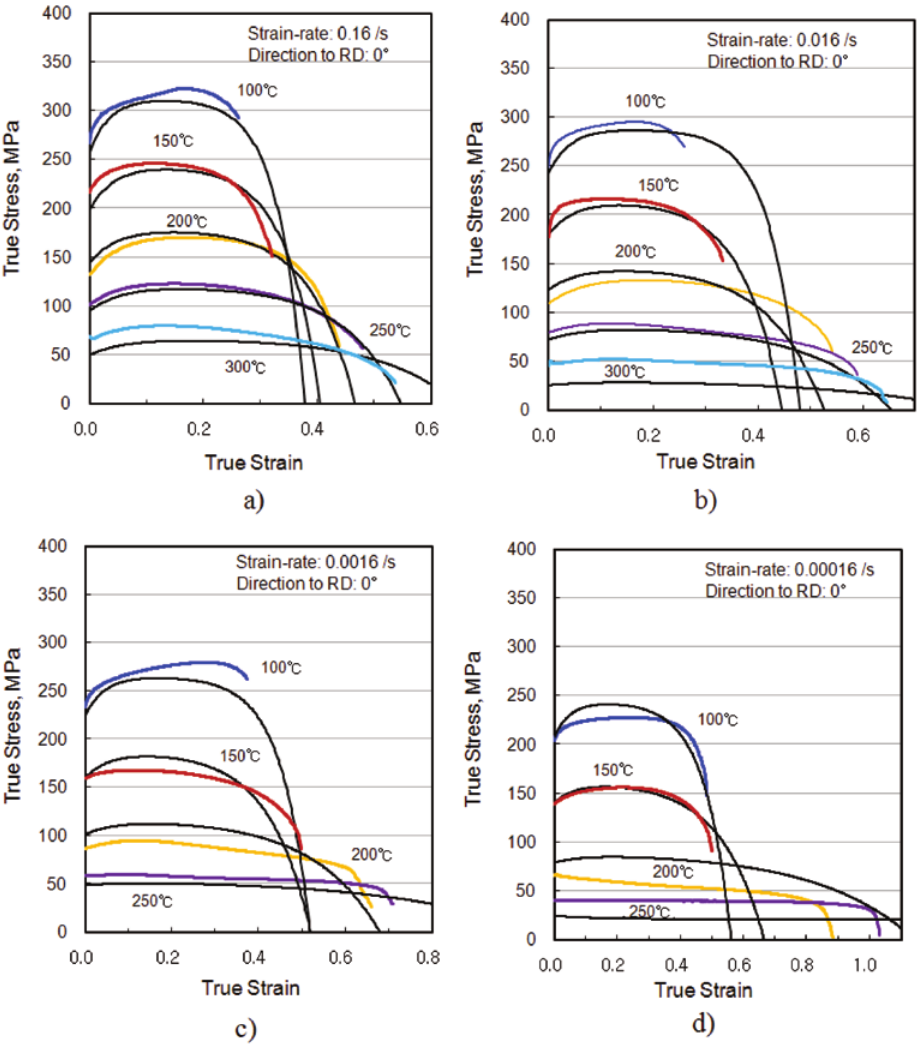
Fig. 5: Comparison between proposed model and experimental flow stress curves at elevated temperatures and strain rates: (a) 0.16/s, (b) 0.016/s, (c) 0.0016/s, (d)